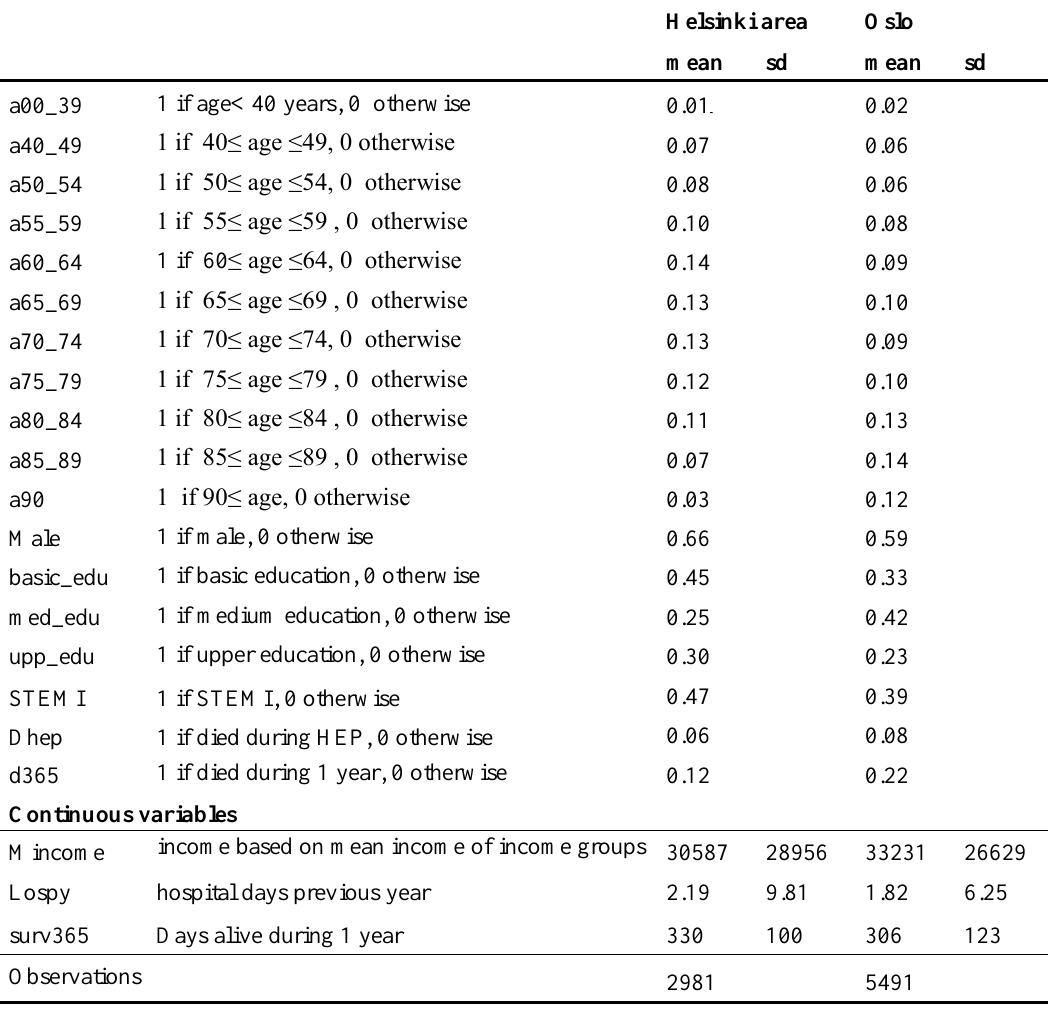
Table A1: Descriptive statistics of patient composition and patient outcome (capital comparison